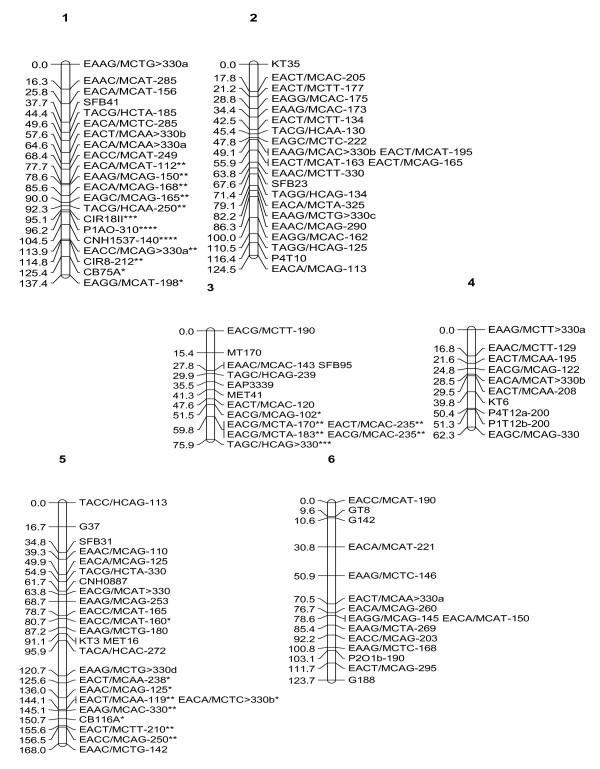
Combined AFLP, SSR and RFLP Map of interspecific hybrid (Palm T128) (Linkage Groups 1–6). Single asterisk: skewed marker at P < 0.1; double asterisk: skewed marker at P < 0.05; three asterisks: skewed marker at P < 0.01; four asterisks: skewed marker at P < 0.005; five asterisks: skewed marker at P < 0.001; six asterisks: skewed marker at P < 0.0005.